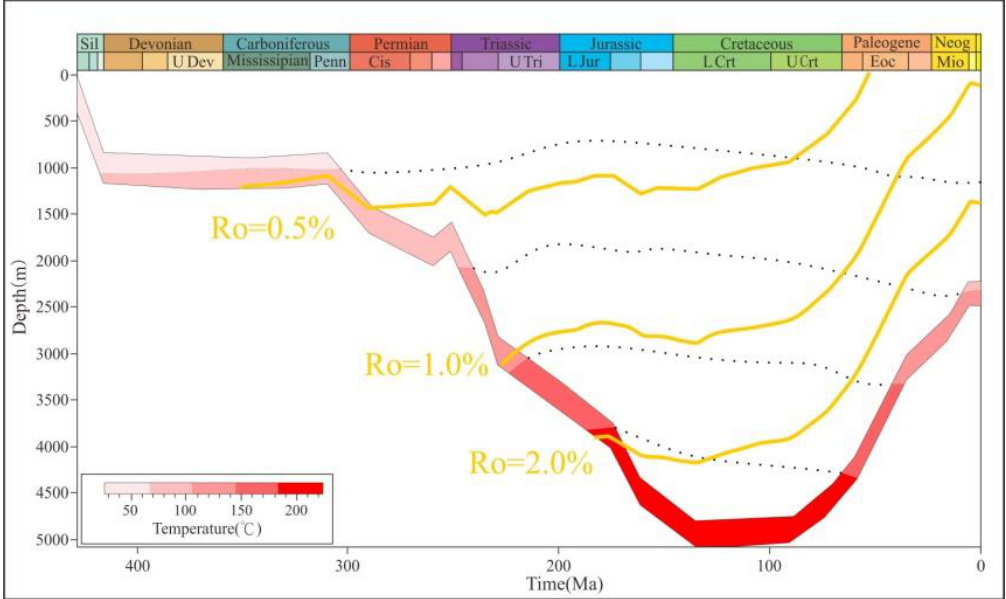
Figure 6. Modeling results of well CN. Burial, thermal and maturity histories of the O 3 w – S 1 l black Figure6. ModelingresultsofwellCN.Burial, thermalandmaturityhistoriesoftheO 3 w–S 1 shales.